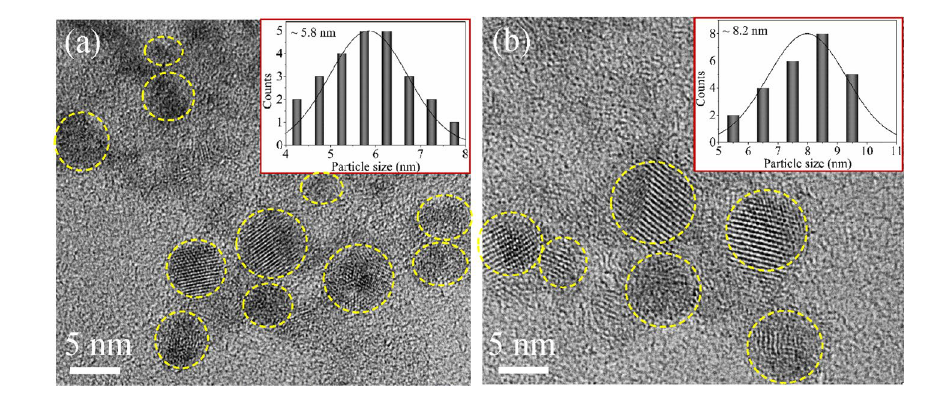
Fig. 3 HRTEM image and cor- responding SAED pattern of the samples, S